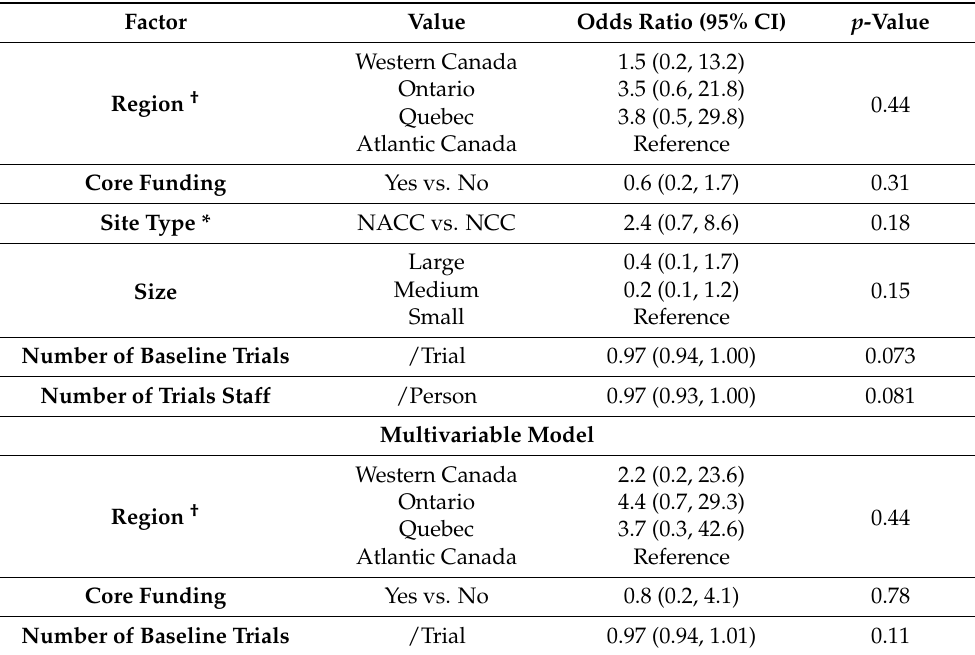
Table 5. Prognostic factors of meeting Year 4 (1 April 2017–31 March 2018) accrual